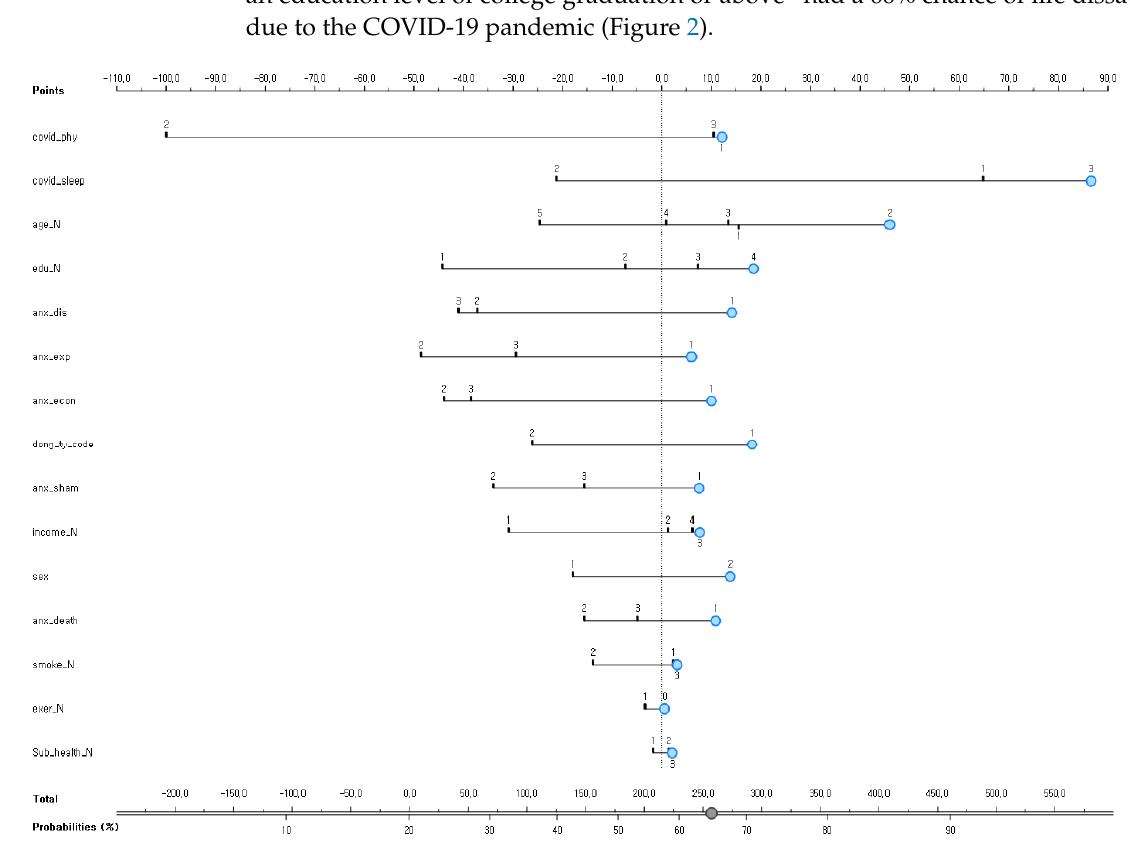
Figure 2. A Bayesian nomogram for predicting the subjective life dissatisfaction of Korean adults in COVID-19 pandemic in Korea. covid_phy = number of meetings with friends or neighbors after the outbreak of COVID-19 (1 increased, 2 similar, or 3 decreased); covid_sleep = changes in sleeping hours after the COVID-19 pandemic (1 increased, 2 similar, or 3 decreased); age_N = (1 = 19–29, 2 = 30–39, 3 = 40–49, 4 = 50–59, 5 = 60+years); edu_N = education level (1 elementary school graduation